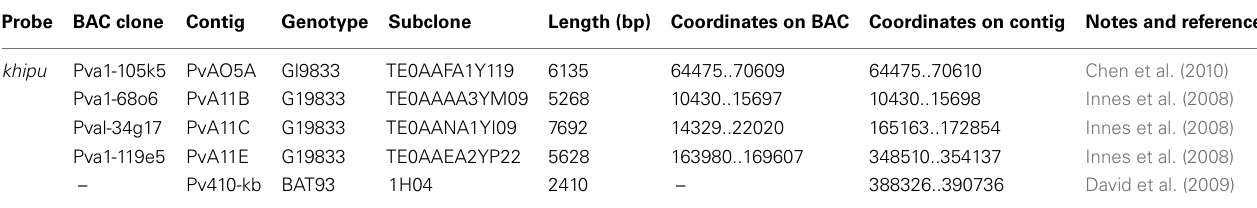
TableA1 | Characteristics of the probes sed for FISH